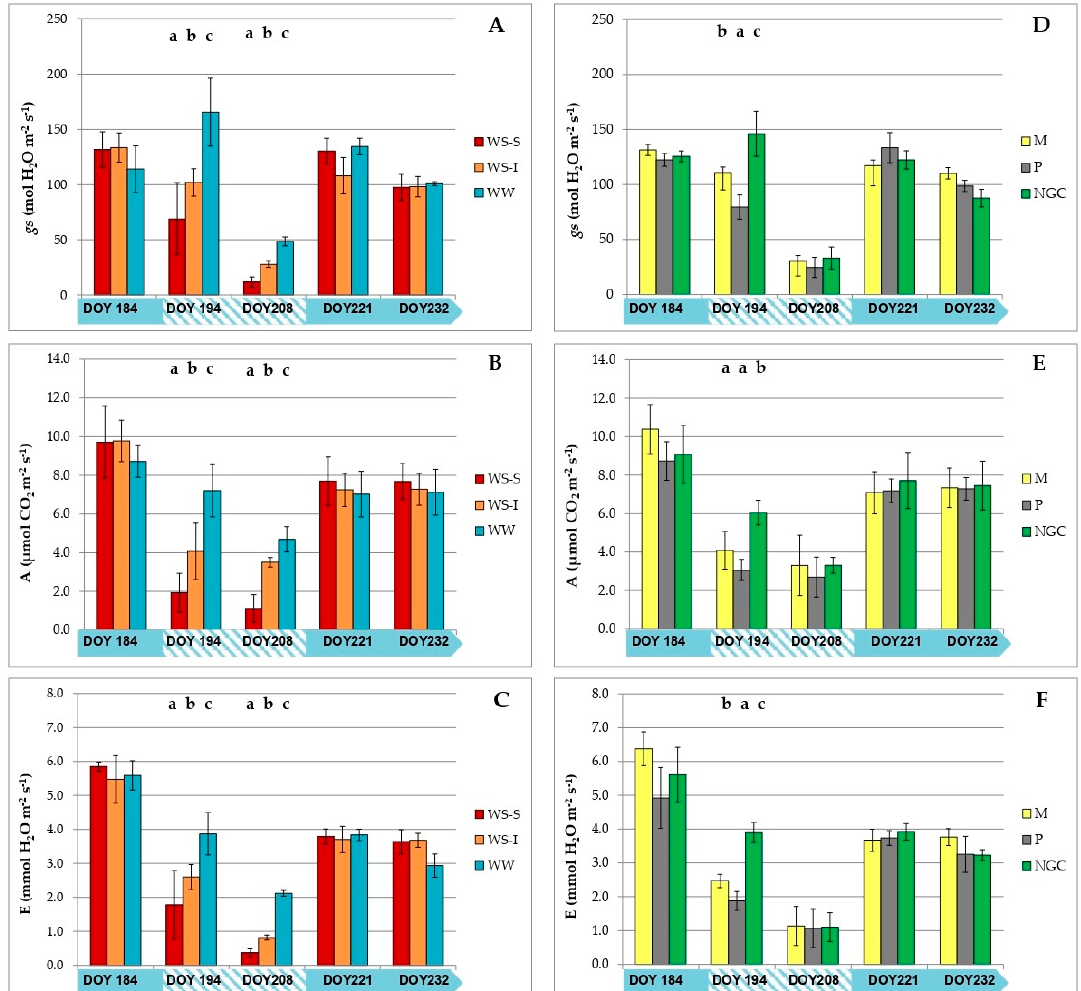
Figure 3. Leaf gas exchange: ( A – C ) Stomatal conductance ( gs ), net assimilation (A), and leaf transpiration (E) in adult leaves of Pinot noir, subjected to three irrigations protocols (WS-S in red, WS-I in orange, and WW in blue); and ( D – F ) stomatal conductance ( gs ), net assimilation (A), and leaf transpiration (E) in adult leaves of Pinot noir grafted on Mgt 101-14 (M, in yellow), 1103 Paulsen (P, in dark grey), and not grafted vines (NGC, in green). The measurements were conducted before (DOY 184), during (DOYs 194 and 208, marked with dashed lines), and after (DOYs 221 and 232) the water stress trial. The bars indicate the standard error. Different letters indicate significant differences (LSD test, P < 0.05).